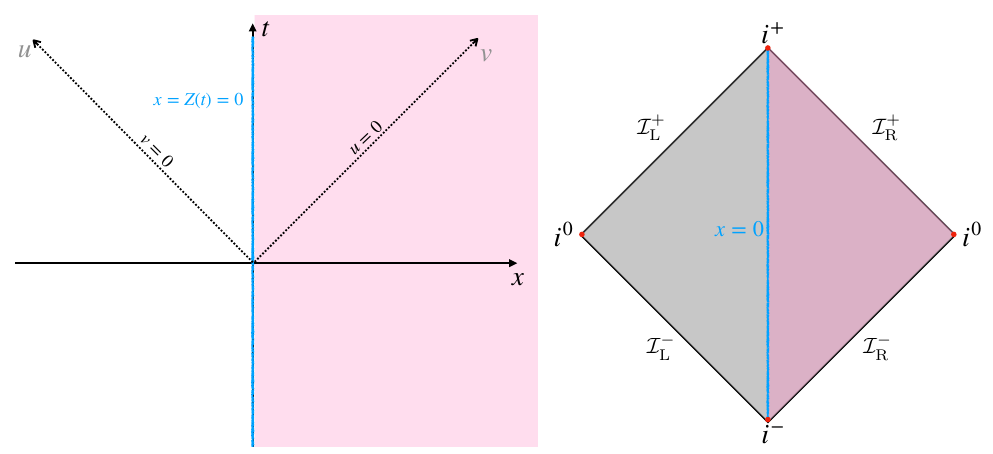
Figure 2 . Minkowski spacetime with a static mirror located at x = 0